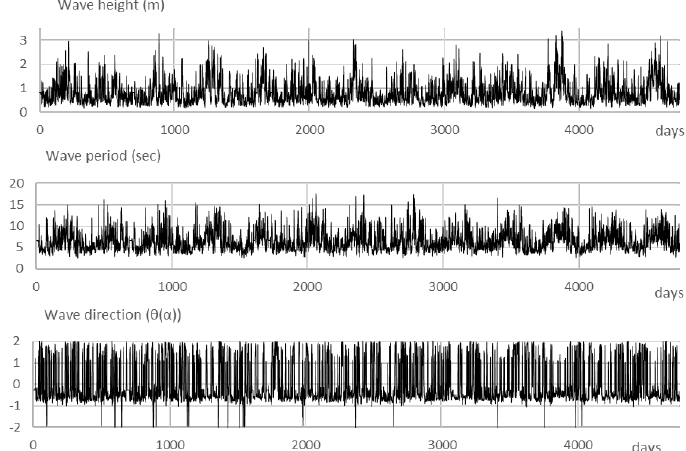
Figure 4. Time series of the observed daily wave data over the period 1 July 2003 to 30 June 2016. The horizontal axis shows days from the start of the period. The top panel shows wave heights, the middle panel shows wave periods and the bottom panel the transformed wave direction.